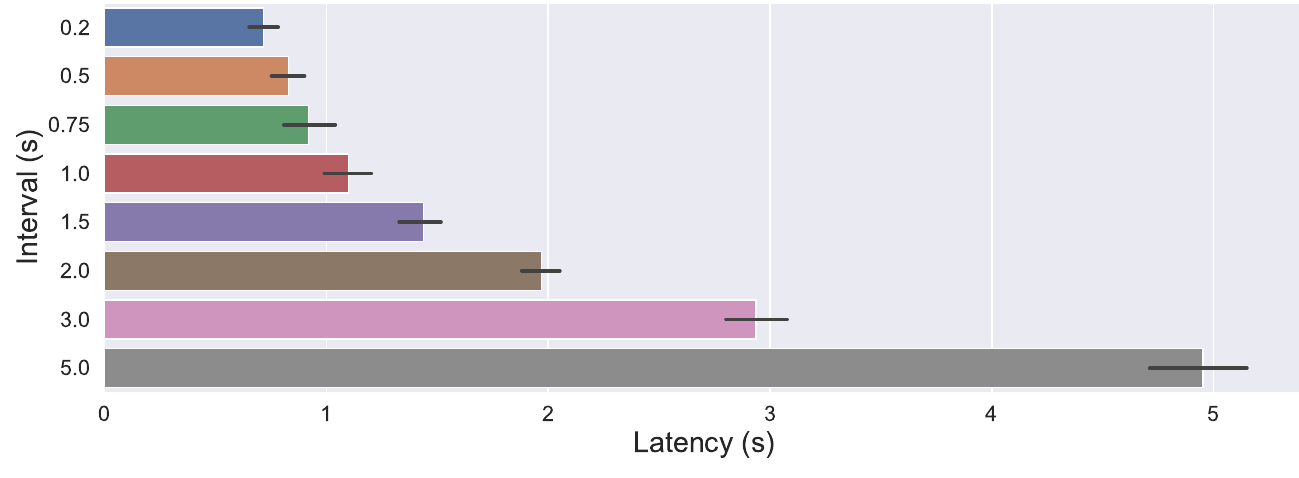
Figure 8. Results of the latency